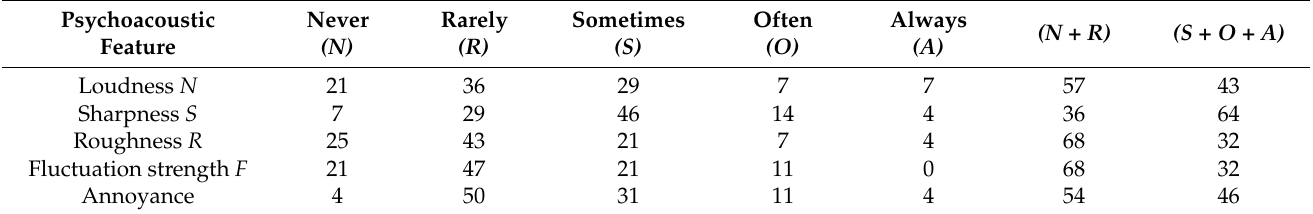
Table 7. Occurrence percentages of responses [%] to questions asked in survey 2 for each psychoa- coustic